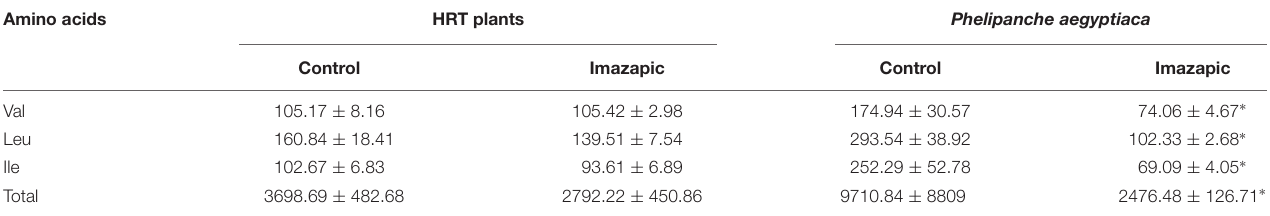
TABLE 1 | Effect of imazapic (38.4 a.i. ha − 1 ) applied to the foliage on soluble branched-chain amino acid content (nM g − 1 FW). Amino acids